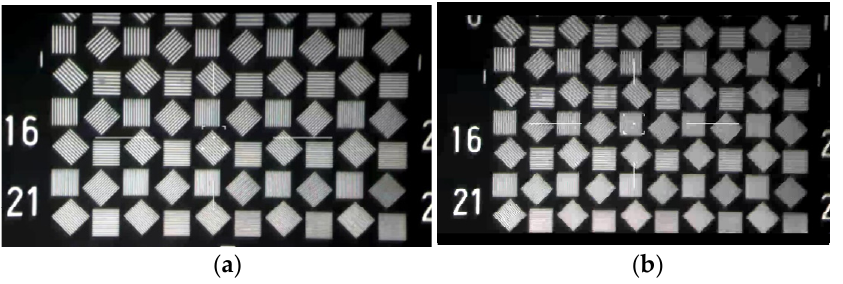
Figure 13. Target images acquired at different temperatures. ( a ) At the temperature of 20 °C. ( b ) At the temperature of − 10 °C.